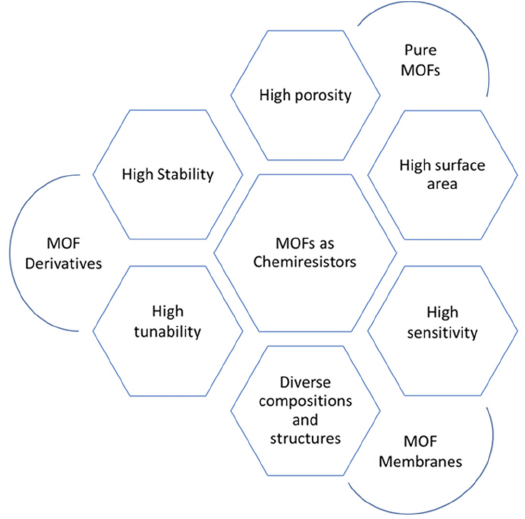
Figure 5. MOFs as chemiresistor sensors, with their properties and different forms.